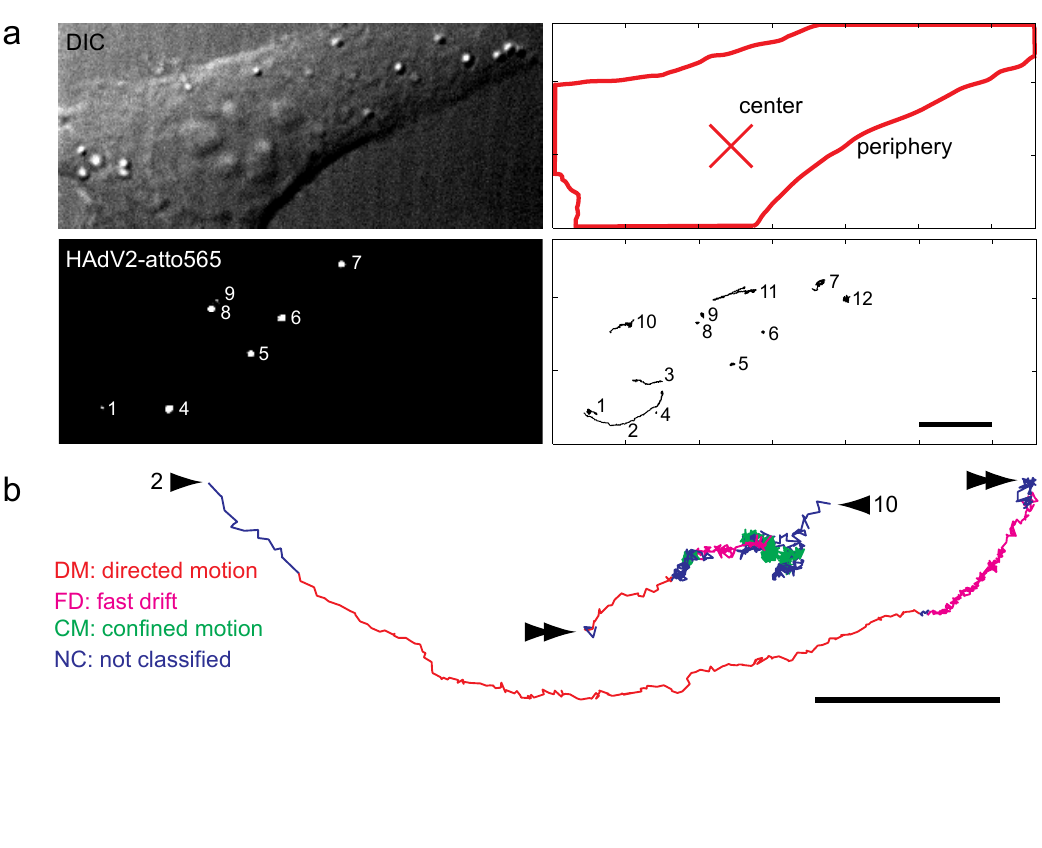
Figure 2. Live cell imaging and trajectory segmentations reveal distinct HAdV motion patterns. ( a ) HeLa cells were infected with HAdV2-atto565, and imaged between 30–90 min p.i. Time stacks were processed with a particle tracker yielding single virus trajectories. Trajectories of viruses that are visible for at least 100 frames are show. The size and intensity of the signal recorded from the virus particles depends on the imaging plane, and the particles brightness. Viruses and corresponding trajectories are numbered (1–12). Please note that virus 1 gives rise to trajectories 1–3, for example, since this virus is moving in and out of the imaging plane (see also Supplemental Movie 1). Trajectories 10–12 are from viruses that are not visible in the particular still image, but are visible in the supplemental movie. Scale bar 8 μ m, cross indicates the center of the nucleus. ( b ) Directed motions (DM, red), fast drifts (FD, pink), confined motions (CM, green) and not classified (NC, blue) as identified machine learning and trajectory segmentation. Arrow head indicates the start, double arrow heads the end of two trajectories, and numbers correspond to particles and trajectories in panel (a). Scale bar 2 μ m. ( c ) The number of motion steps of a particular motility type is shown as a fraction of the total number of motion steps. The median and the 95% confidence interval obtained by bootstrapping are shown; n = number of tracks. ( d ) The directionality of the motion segments from the data set in (c) was classified as described in the Materials and Method section with the median and the 95% confidence interval obtained by